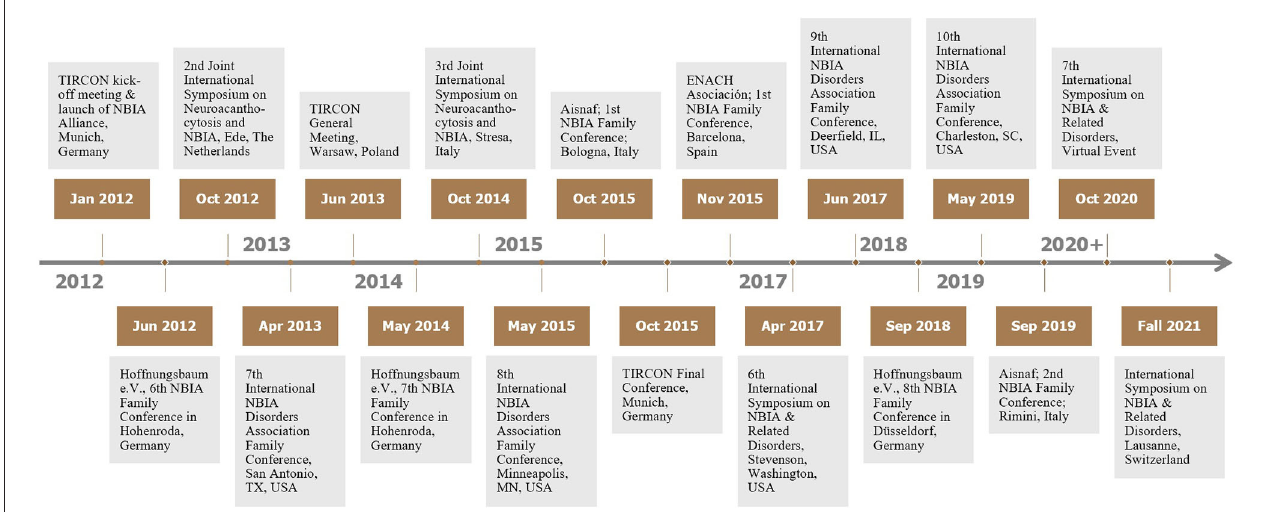
FIGURE 5 | Major NBIA events since 2012—TIRCON meetings, scientific symposia, family